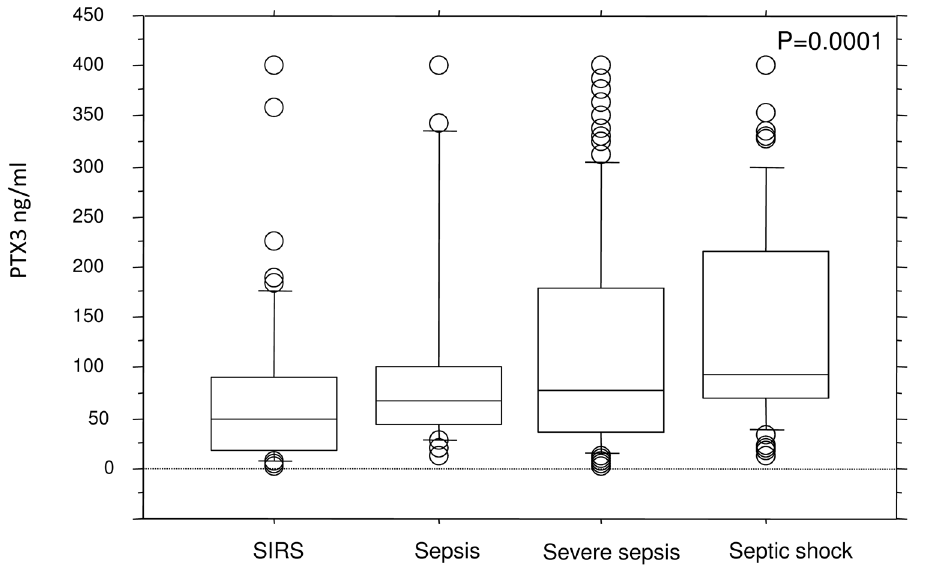
Figure 3. Serum levels of PTX3 in patients classified as having SIRS (n=73), sepsis (n=26), severe sepsis (n=97) and septic shock (n=65), (Kruskal-Wallis, p=0.0001) are shown. Ranges, interquartile ranges and medians are indicated. Using a Dunn’s post test revealed that only the SIRS group differed significantly from the other groups (p , 0.05), while no significant difference was observed between the sepsis, severe sepsis and septic shock groups (p .